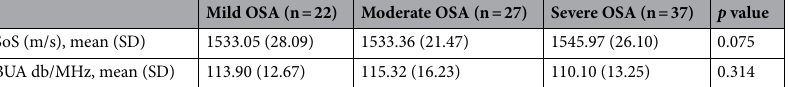
Table 3. Comparison of the parameters of QUS of the calcaneus [speed of sound (SoS) and broadband ultrasound attenuation (BUA) in children with difference severity of OSAS (n = 86)]. Remarks : one-way ANOVA was used to investigate the mean differences for BUA and SOS (normal distribution based on skewness and kurtosis in between − 2 and 2) among children with difference severity of OSAS. Equal variances were assumed ( p > 0.05). SD standard deviation.